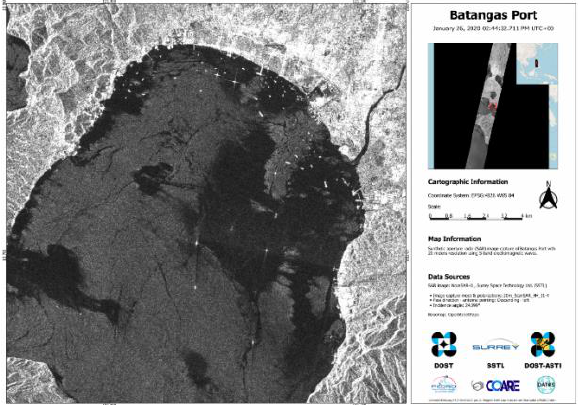
Figure 1 . SAR image capture of Batangas City Port using ScanSAR mode, 2019 © SSTL.